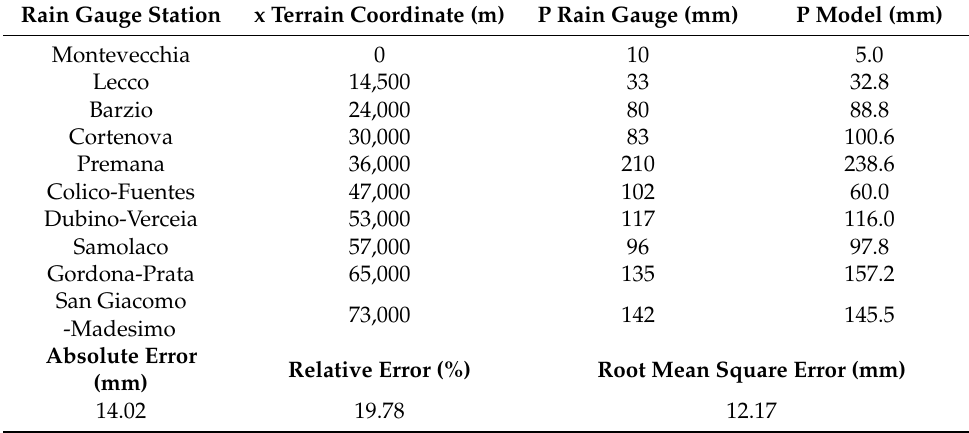
Table 6. Rain gauge comparison with model precipitation field and errors assessment. Rain Gauge Station x Terrain Coordinate (m) P Rain Gauge (mm) P Model (mm)